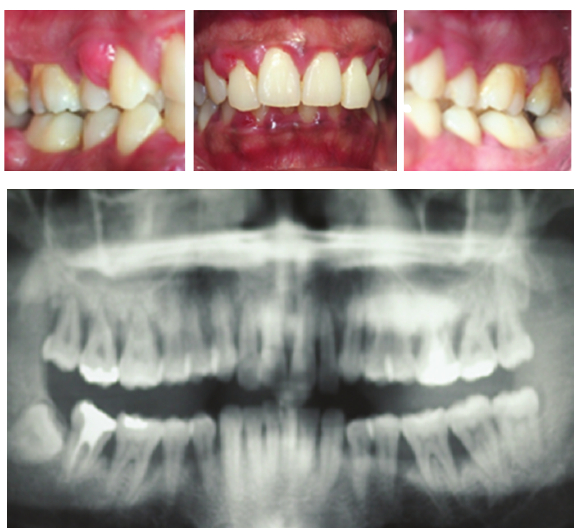
Figure 1: Clinical views of aggressive periodontitis a ff ecting pregnant women. Major clinical signs are gingival inflammation and alveolar bone destruction. (Courtesy to Dr. Bouaziz